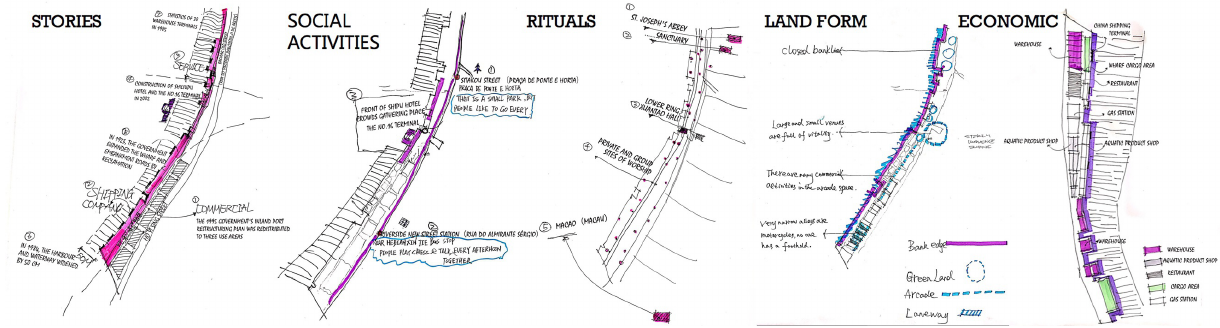
Fig. 1 Sketch of the stratified analysis of Macao Inner Harbour. Source : Drawing by Urban Planning PhD Students of the City University of